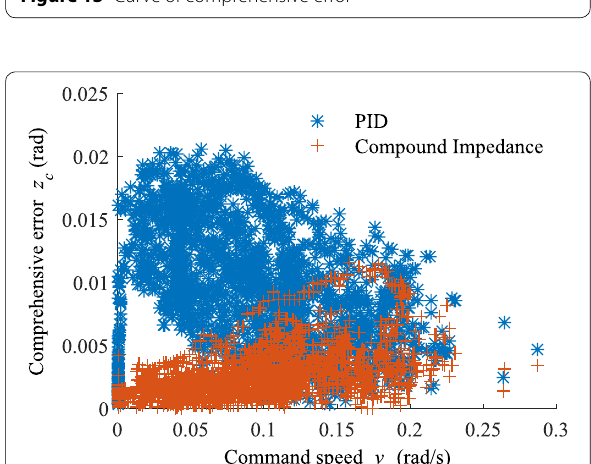
Figure 13 Curve of comprehensive error